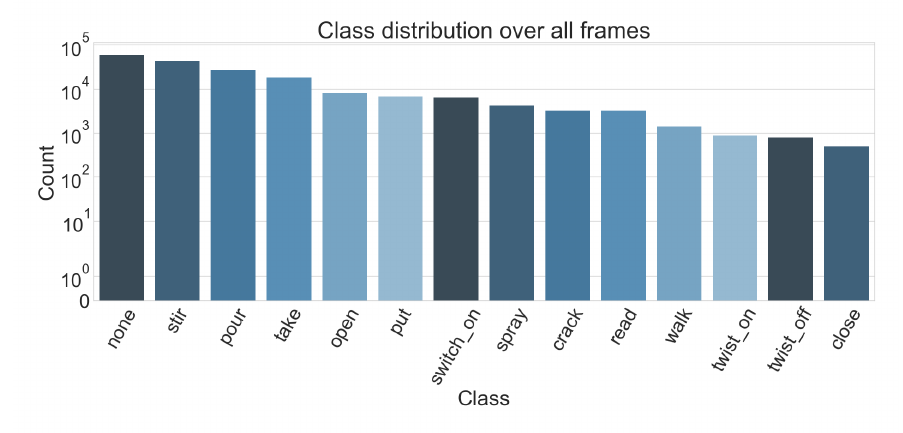
Figure 9. Distribution of the classes we consider from the CMU-MMAC dataset. The class label is derived from the verb part of the original